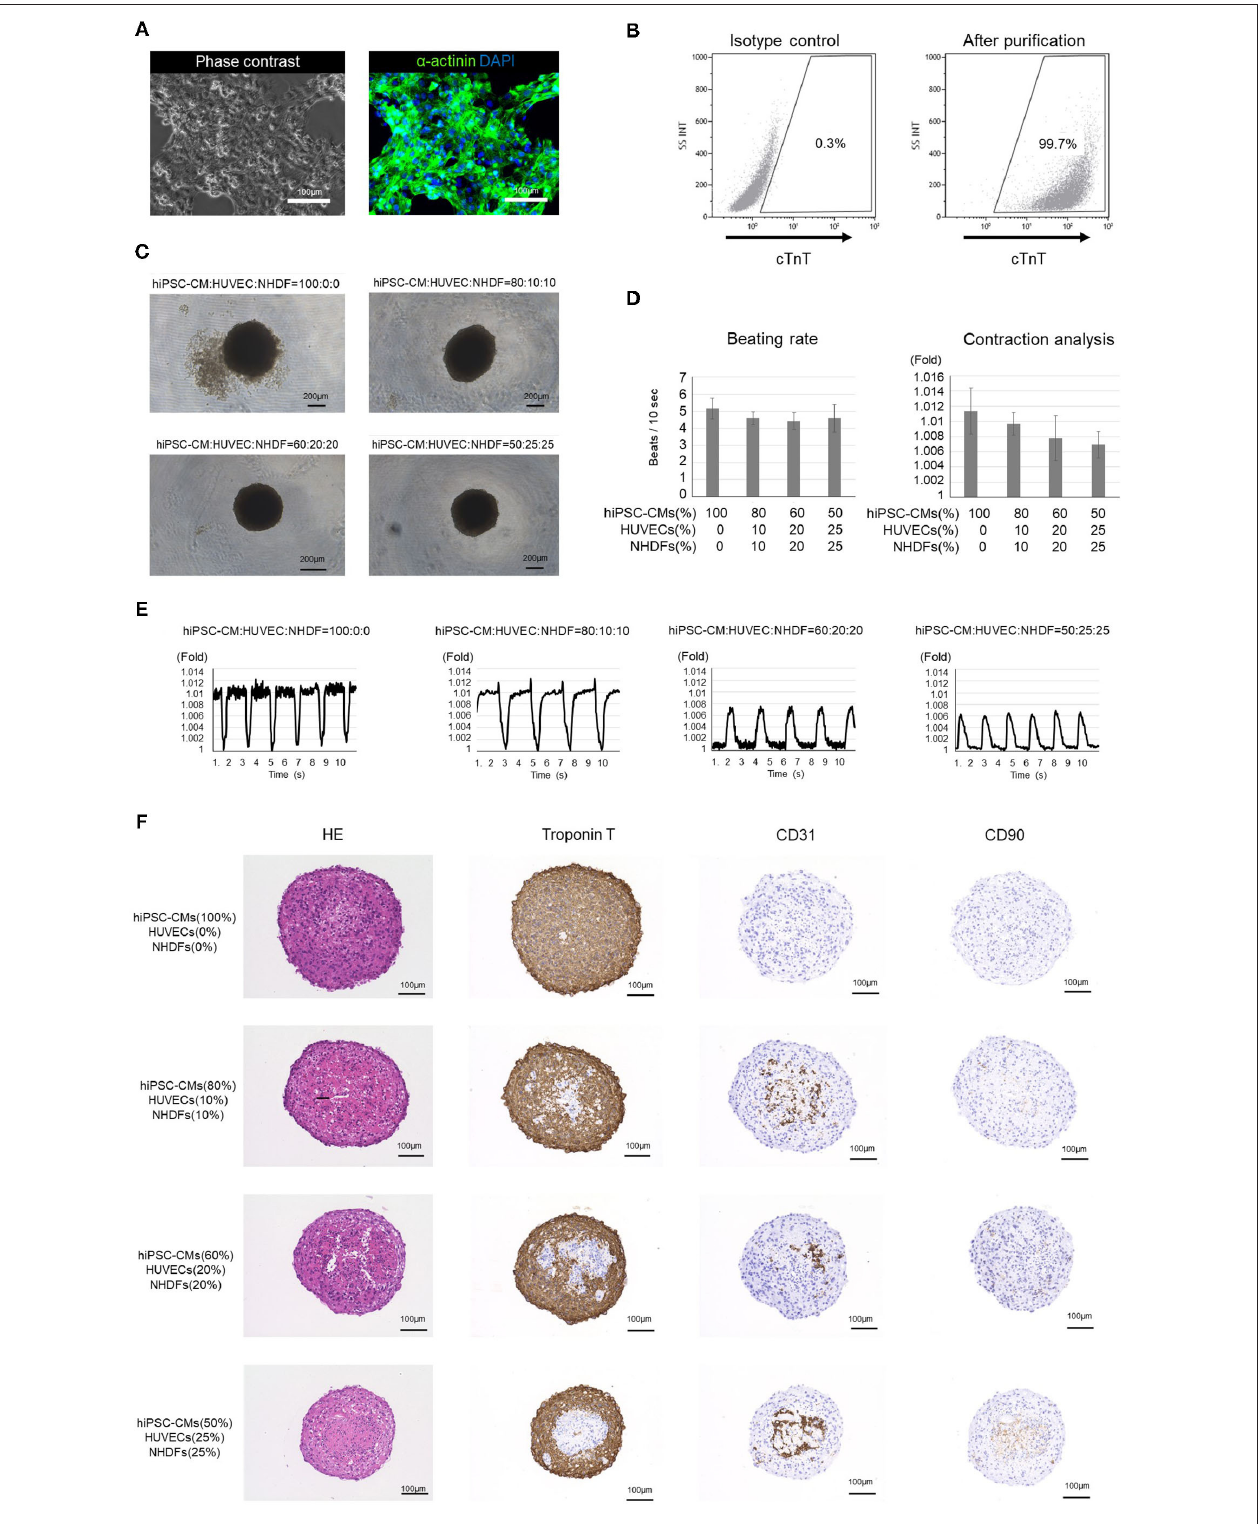
FIGURE 1 | Analysis of human induced pluripotent stem cell-derived cardiomyocytes (hiPSC-CMs) and cardiac organoids (COs). (A) Phase contrast image and immunostaining of purified hiPSC-CMs. (B) Flow cytometry of purified hiPSC-CMs. The proportion of cardiac troponin T-positive cells is > 99%. (C) Outline